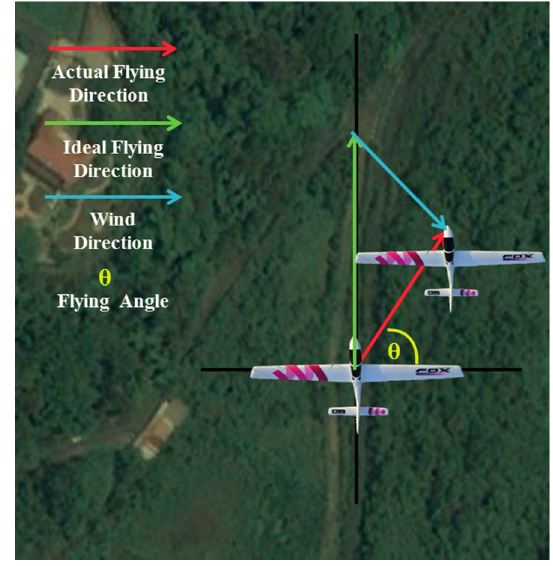
Figure 6. Flying direction changed by